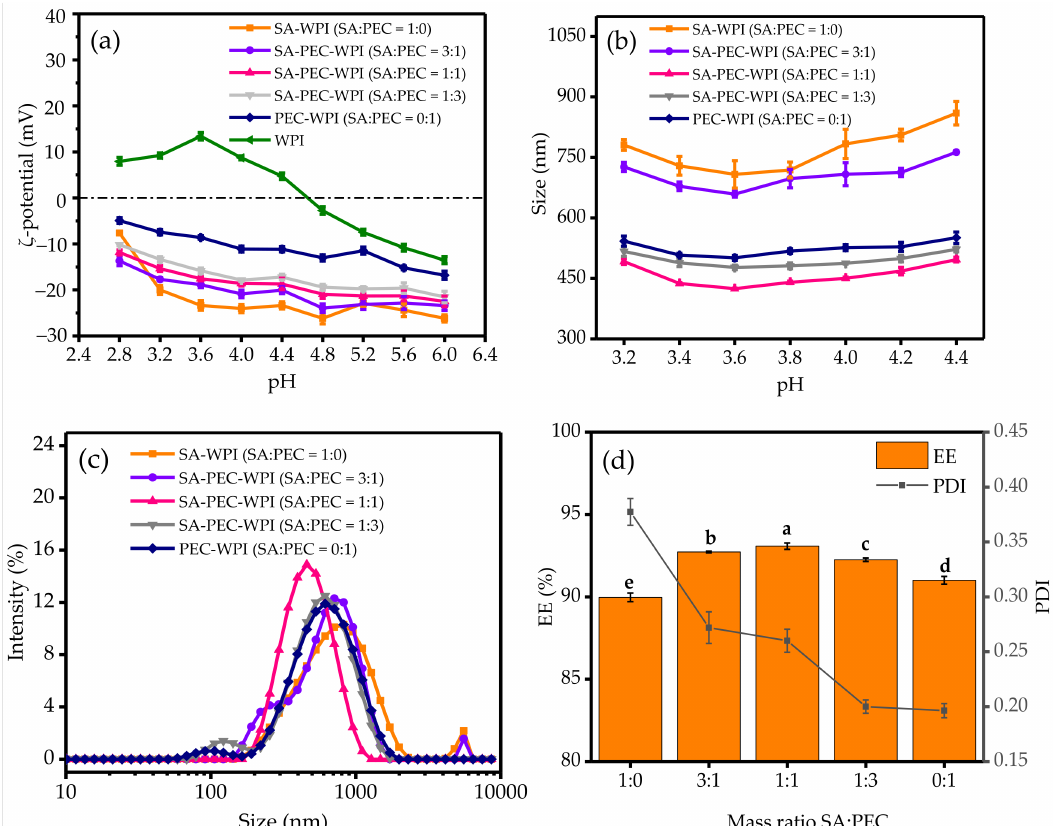
Figure 1. The zeta potential ( a ) and particle size ( b ) of emulsions at different SA:PEC mass ratios and pH values. The particle size distribution ( c ) of different emulsions at pH 3.6. The EE and PDI ( d ) of SA-PEC-WPI emulsions with β -carotene concentration of 40 mg/L at pH 3.6. The different letters (a–e) within figure indicate significant differences ( p ≤ 0.05). EE: encapsulation efficiency; PDI: polymer dispersity index; SA: sodium alginate; PEC: pectin; WPI: whey protein